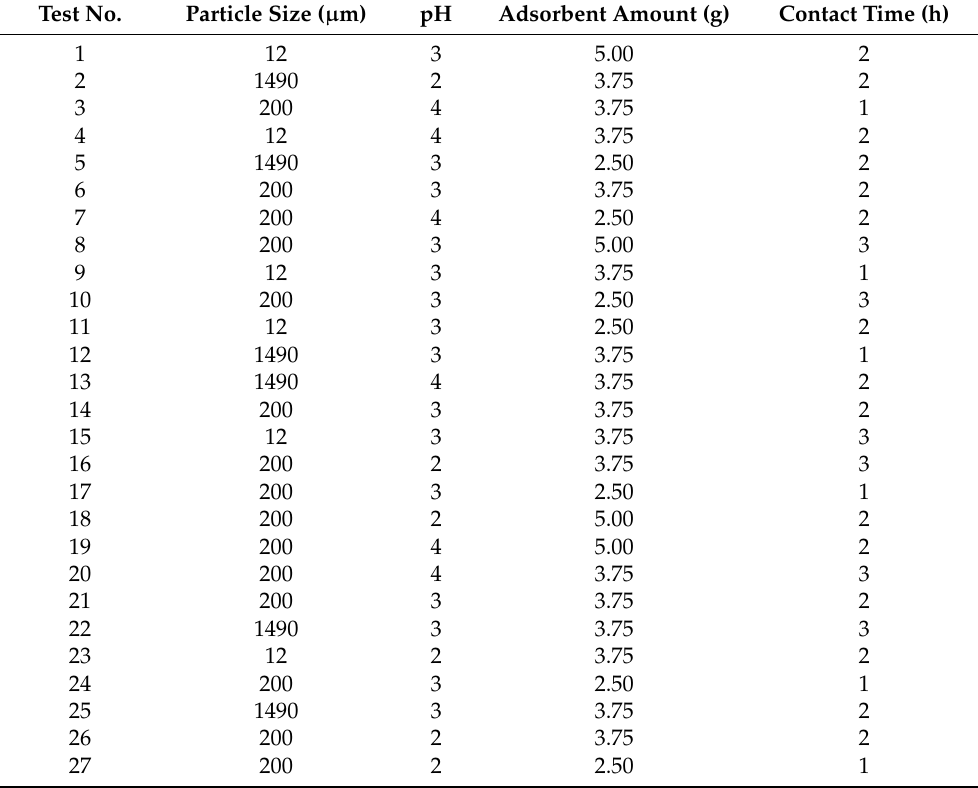
Table 2. Detailed operating conditions of the adsorption tests. Test